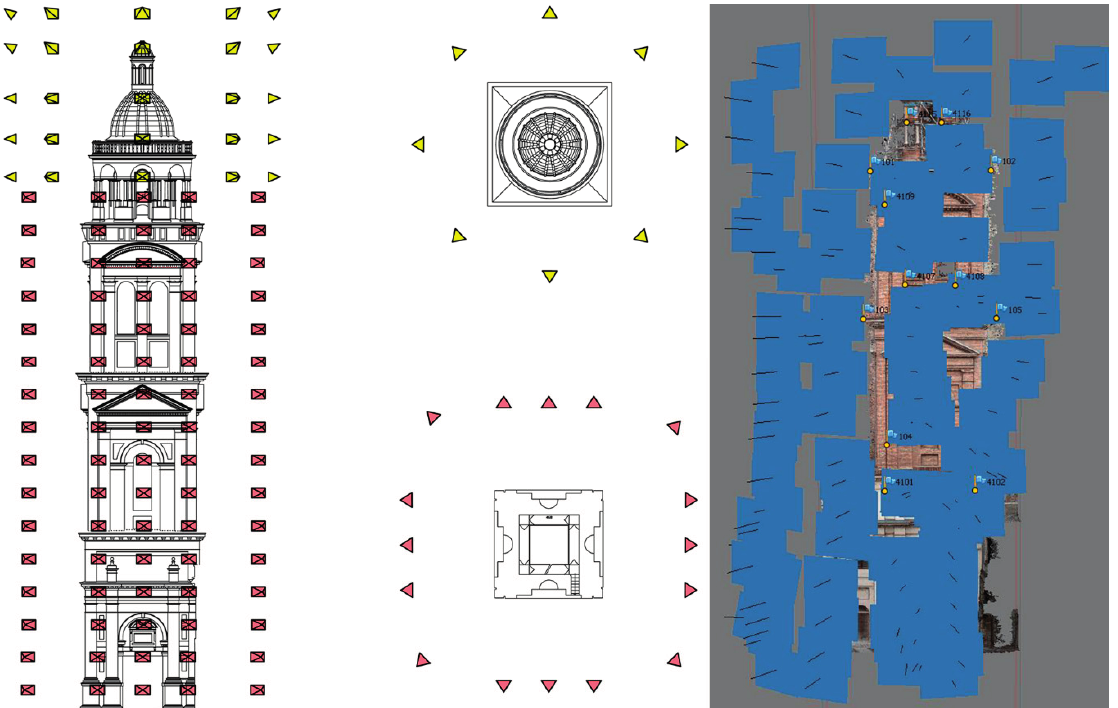
Figure 7. Design of UAV image acquisition. In red the images for the front of the bell tower, in yellow for the round temple. Result of image orientation. The difference between project and real flight are